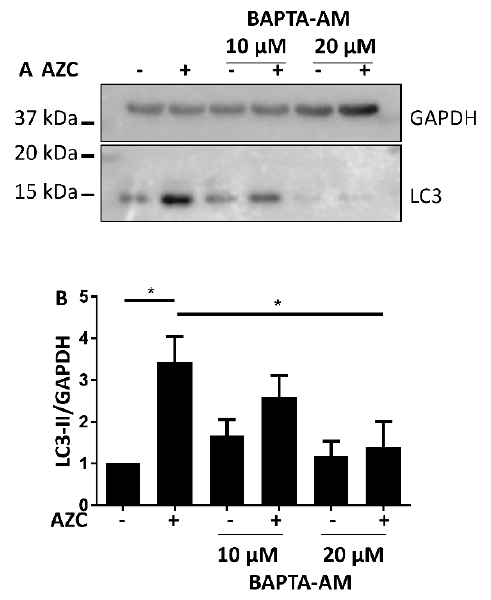
Figure 5. AZC elevates LC3-II levels in a Ca 2+ -dependent manner. Cells were treated for 6 h with 5 mM AZC in absence or presence of 10 µ M or 20 µ M of the intracellular Ca 2+ chelator BAPTA-AM, and during the last 4 h 100 nM Baf A1 was added. ( A ) A representative blot of six independent experiments each performed in duplicate, assessing protein levels of the autophagy marker LC3-II. Glyceraldehyde 3-phosphate dehydrogenase (GAPDH) was used as loading control. ( B ) Quantification of LC3-II levels in ( A ) shown as mean ± SEM relative to untreated control. * p < 0.05.